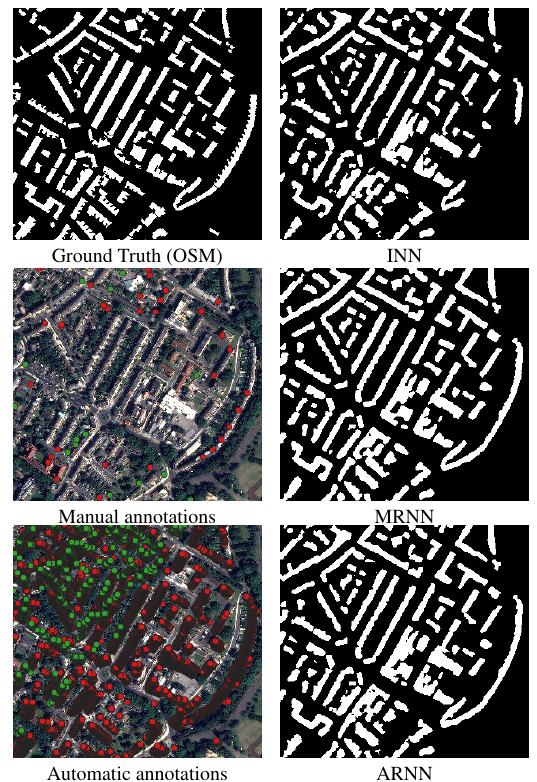
Figure 4. Meshed DSMs on Montpellier (France). Our proposed 3SGM optimization helps recover main streets elevations.